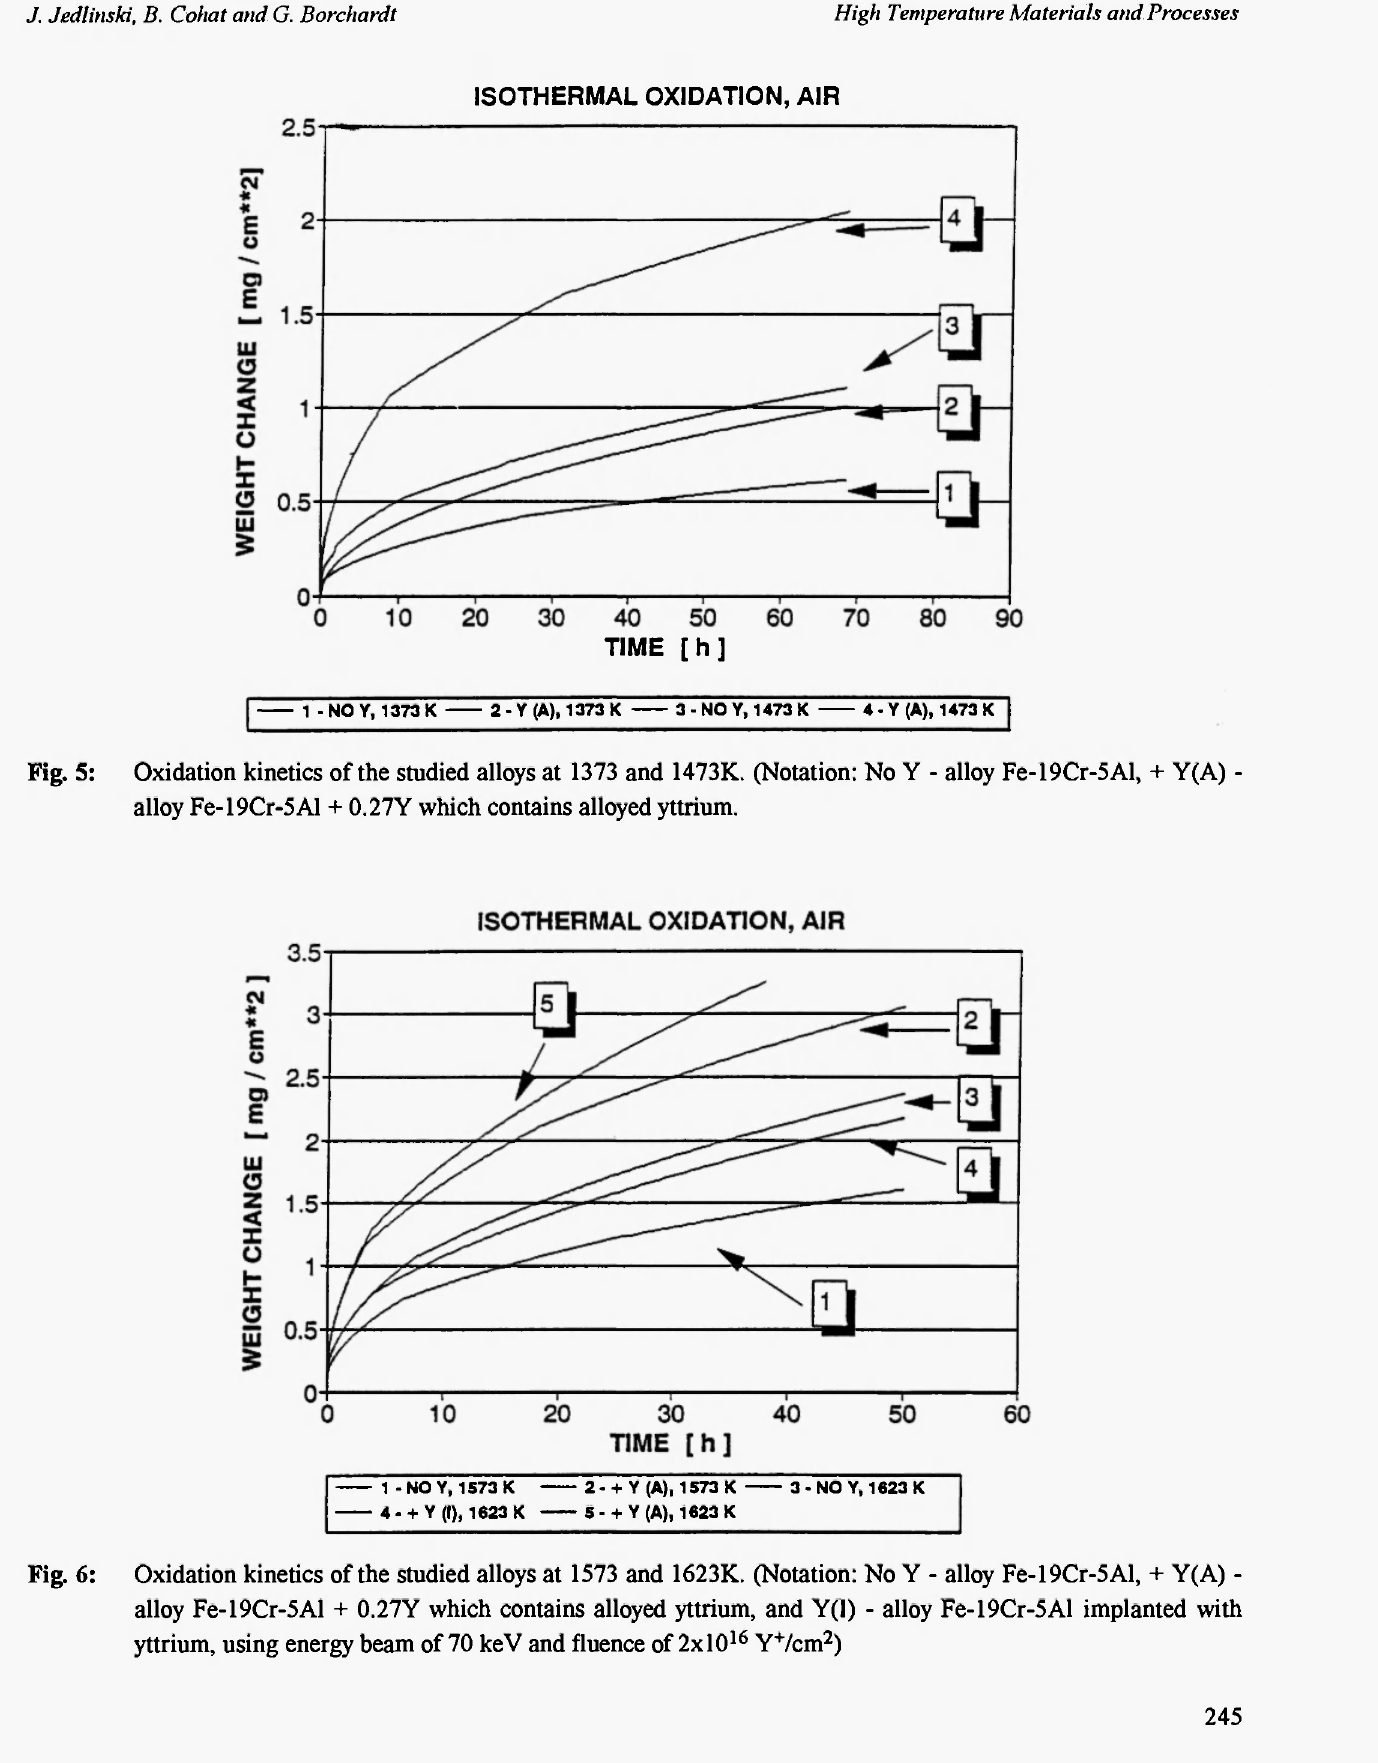
Fig. 5: Oxidation kinetics of the studied alloys at 1373 and 1473K. (Notation: No Y - alloy Fe-19Cr-5Al, + Y(A) - alloy Fe-19Cr-5Al + 0.27Y which contains alloyed yttrium.